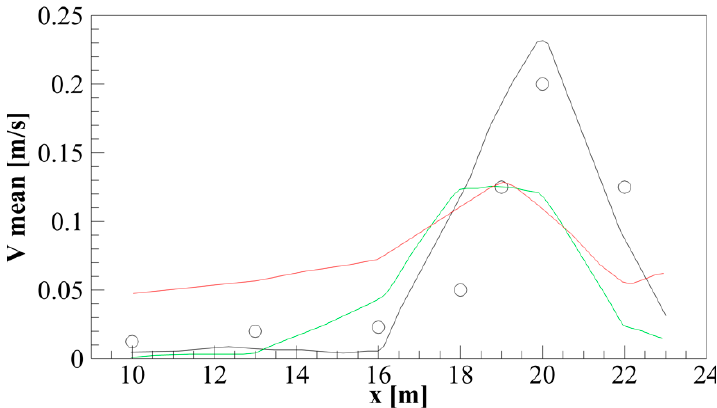
Figure 12. Test 4. Rip current. Time average of the near-bottom offshore-directed cross-shore velocity component along the rip channel. Experimental data from Hamm [24] (circles); WTENO model (black line); 2TVD model proposed by Cannata et al. [3] (red line); 5WENO model (green line).